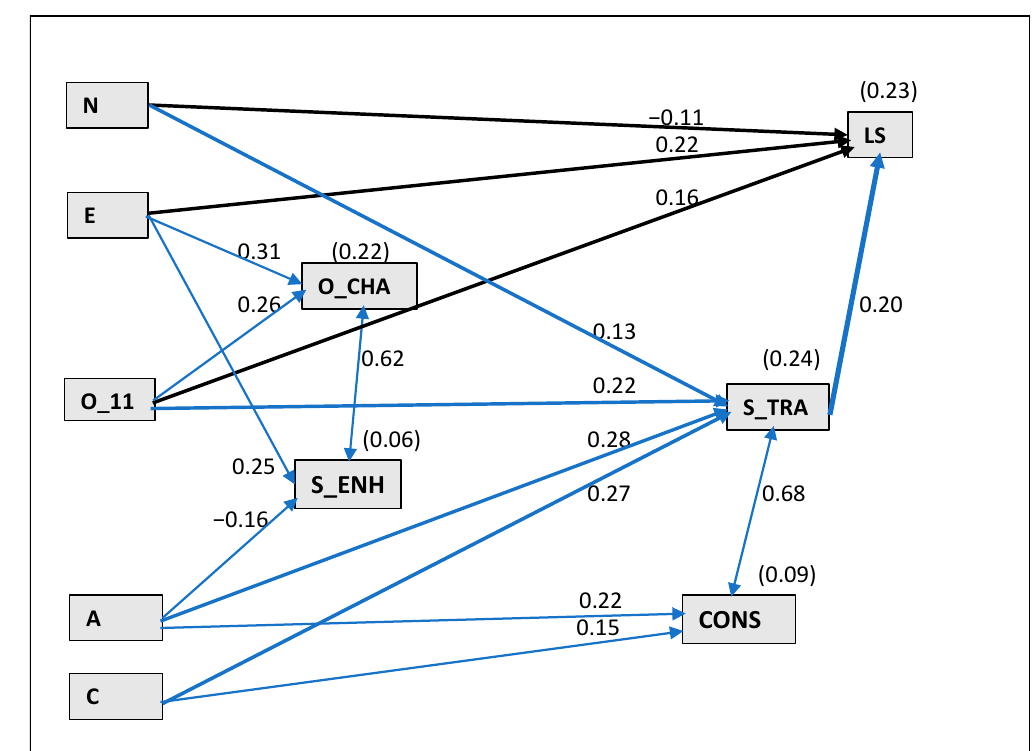
Figure 1. The model of relationships between FFM traits, meta-values and life satisfaction with standardized path coefficients. Note: FFM traits: N—Neuroticism, E—Extraversion, O_11—Openness to experience (based on 11 items), A—Agreeableness, C—Conscientiousness; Meta-values: O_CHA— Openness to change, S_ENH—Self-enhancement, CONS—Conservation, S_TRA—Self-transcendence; LS—Life satisfaction.